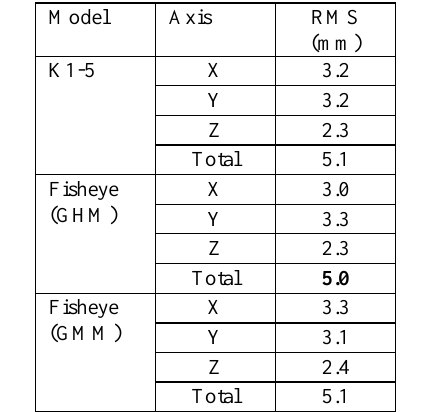
Table 6. RMS of object-space residuals on checkpoints for GoPro camera in check adjustment using parameters estimated from various models, based on 3D target field observations.